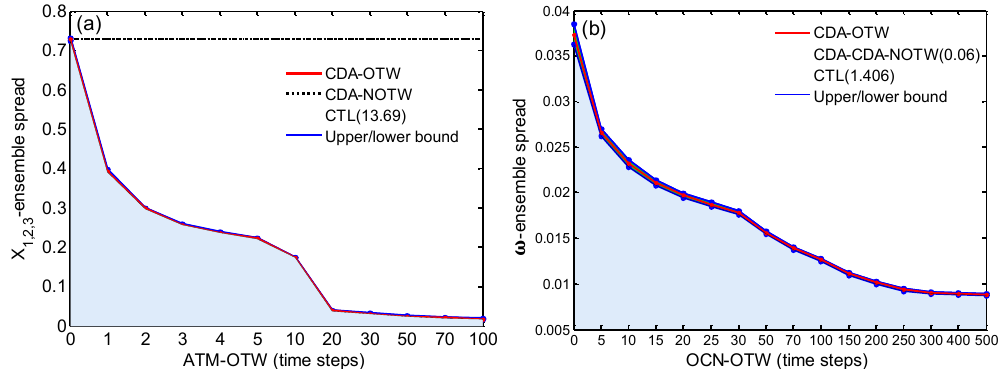
Figure 5. Same as panels (a) and (b) in Fig. 4 but for the variation of ensemble spreads of the model states. In panel (b) the optimal ATM- OTW is also set as 1. The area between the lower and upper bounds (blue) represents the range evaluated from the 20 cases. And the blue shadow below the ensemble spreads represents the range of the uncertainty of state estimation in each assimilation